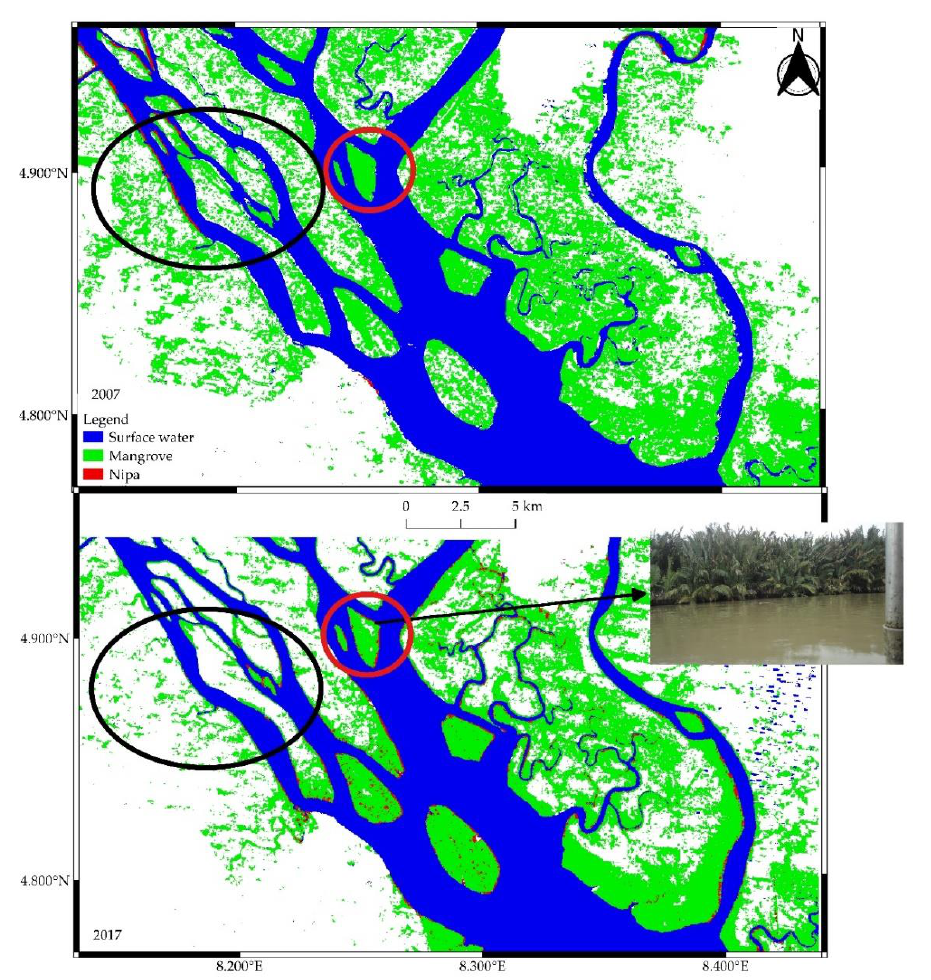
Figure 6. Mangrove forests loss along islands o ff the coast of Akwa Ibom and nipa palm colonization in Alligator Island, Calabar River Estuary of the Niger Delta. Black circles represent mangrove loss while red circles represent Nipa Palm colonization. Inset pictures of study sites during GCP selection.